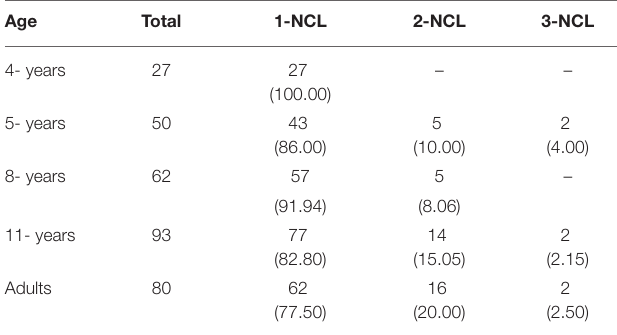
TABLE 1 | Mean number (and percentage) of total sentences, simple sentences, main, and subordinate clauses in complex sentences by age. Total